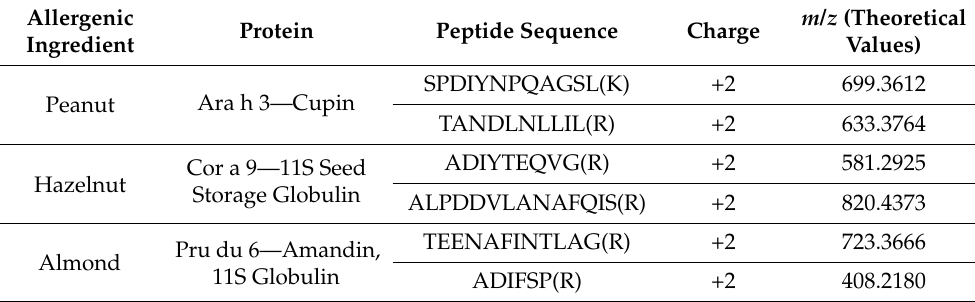
Table 1. Isotopically labelled peptides used as internal standards. The charge state (+2) and the theoretical m / z value of the ion used for each peptide are also